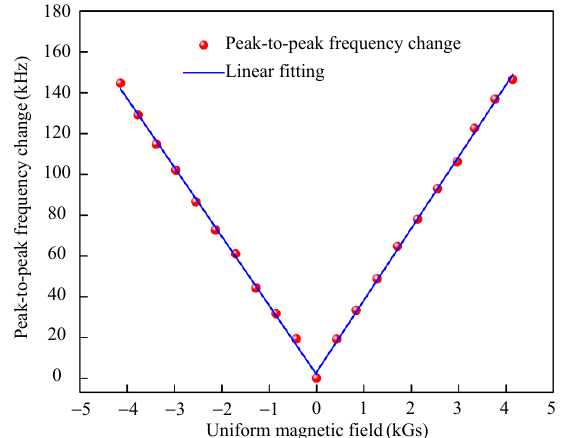
Fig. 5 Beat frequency variation amplitudes for various magnetic flux density. The current is alternating at 12 kHz with peak-to-peak amplitude of 1 A.